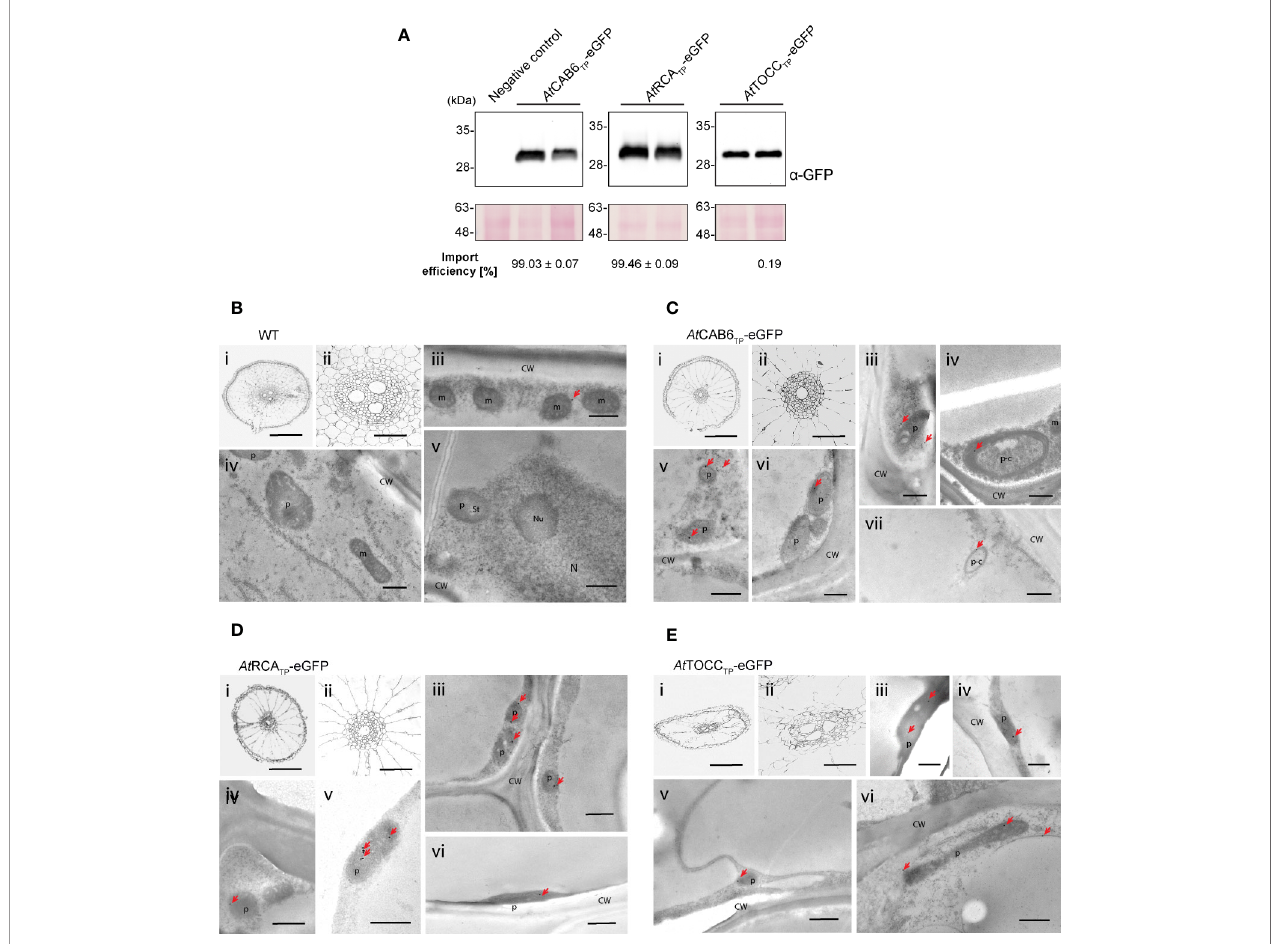
FIGURE 6 | Roots from regenerated rice plants show eGFP targeting into leucoplasts driven by Arabidopsis transit peptides (TPs). (A) Western blot analysis of root total protein extracts from two plants regenerated from the same transformed callus line expressing the indicated constructs above, incubated with anti-GFP antibody. Negative Control represents a wild-type plant. Import ef fi ciency was de fi ned as the percentage of the processed faster-migrating protein form relative to the total amount of expressed eGFP protein. Data shown are means ± SD of three independent extractions. (B-E) Immunogold labeling of eGFP in plastids of rice root cells using a GFP-speci fi c monoclonal antibody (diluted 1:250). (B) Wild-type cells. (C) At CAB6 TP -eGFP. (D) At RCA TP -eGFP. (E) At TOCC TP -eGFP. i: Light microscopy (LM) image of studied section; ii: detail of i (central cylinder); iii – vii: Transmission electron microscope (TEM) images. (CW, cell wall; m, mitochondria; N, nucleus; Nu, nucleolus; p, plastid-like; p-c, plastid showing an isolated cytoplasmic region; bars i = 0.2 mm, ii = 50 µm, iii – vii = 500 nm; gold particle size = 15